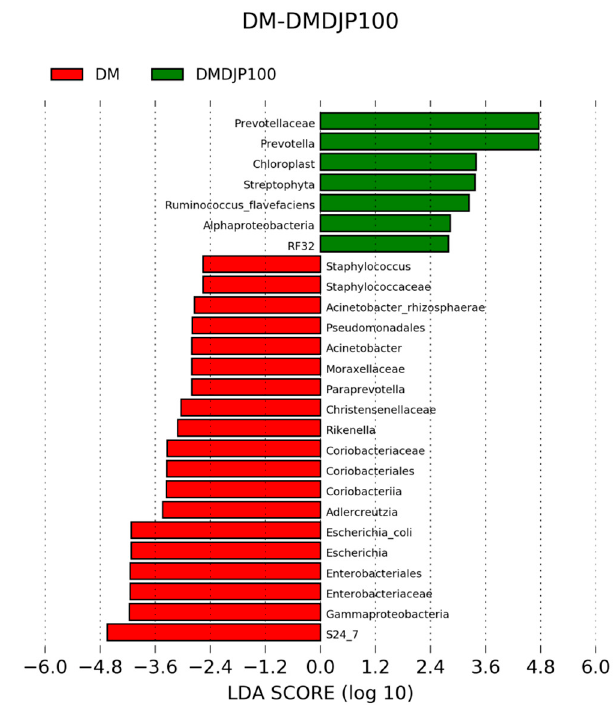
Figure 12. Identification of taxonomic features relevant in DM and DMDJP100 using LEfSe (LDA Effect Size).